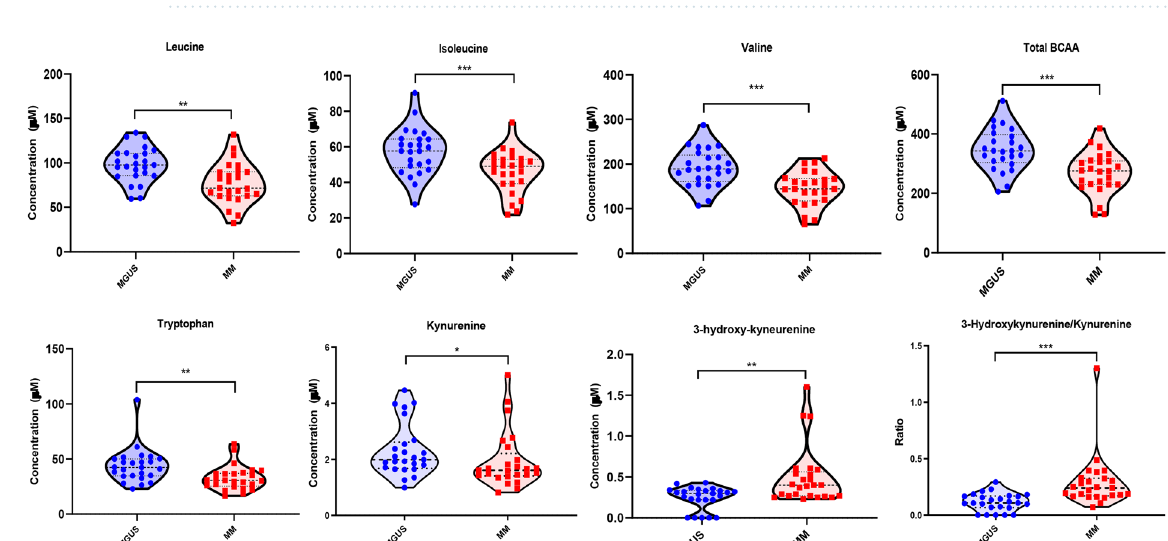
Figure 4. Violin plots comparing the median concentrations of different branched chain amino acid (BCAAs) as well as tryptophan and its catabolites in the bone marrow plasma between MGUS (N = 25) and MM (N = 25) groups. Data was analyzed by Mann-Whitney U test where *** p < 0.001, ** p < 0.01, * p < 0.05, # p < 0.1 but > 0.05, n.s.